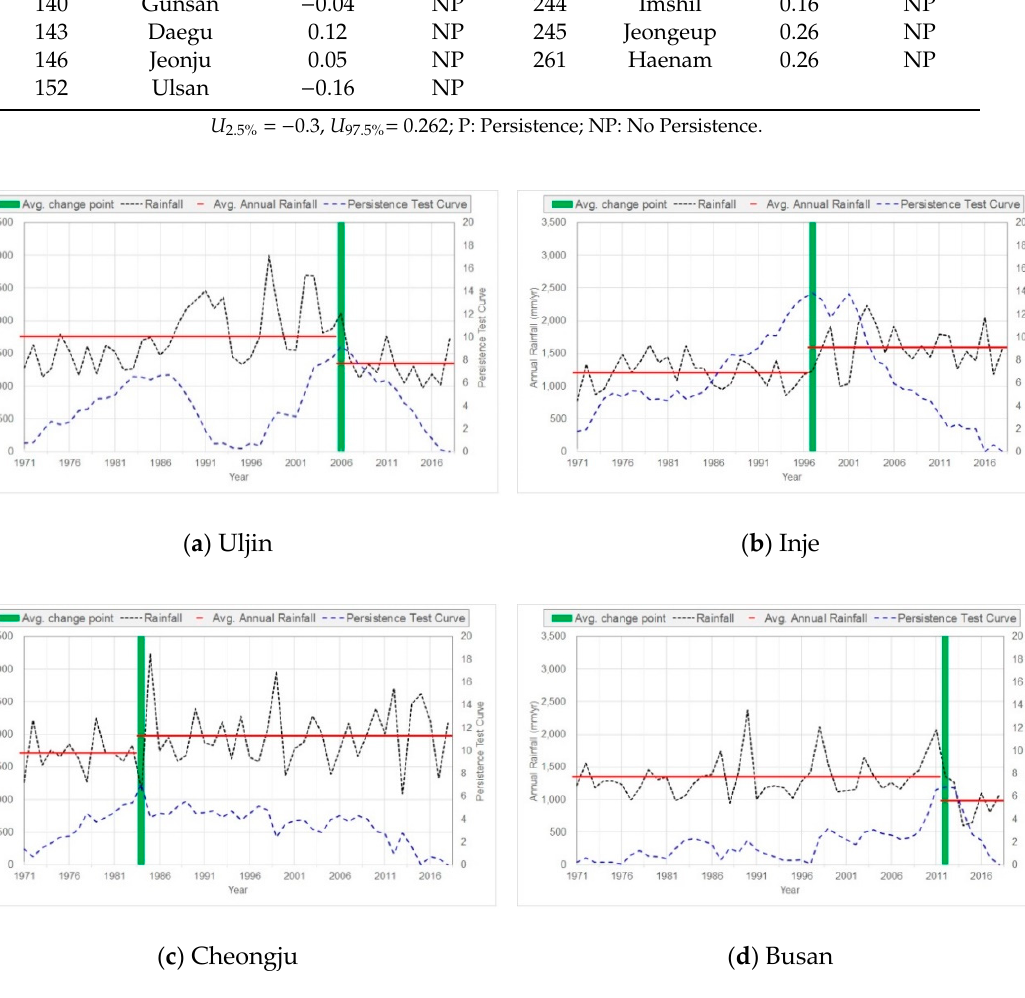
Figure 8. Serial correlation coefficient graphs showing persistence. ( a ), ( b ), ( c ), and ( d ) each represent graphs of Uljin, Inje, Cheongju, and Busan.